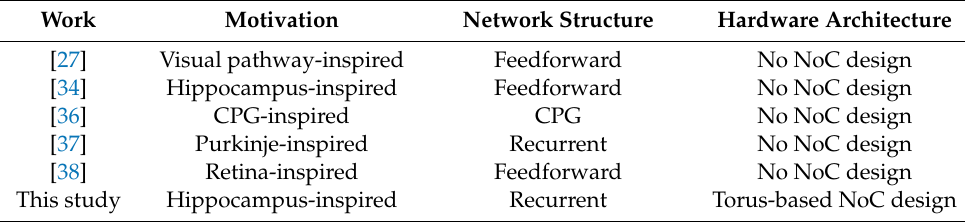
Table 3. Comparison of the presented study with previous